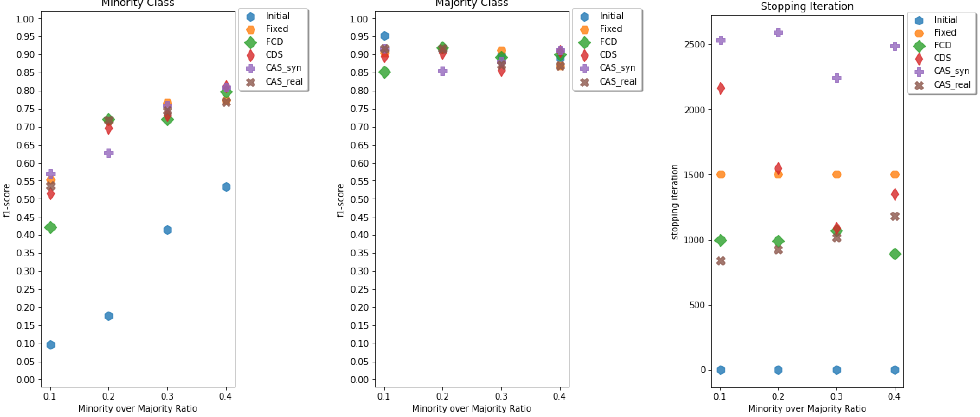
Figure 12. Average F1 results of tor-based datasets by imbalance ratio for minority ( left ) and majority ( center ) classes, and average number of iterations until the training is stopped ( right